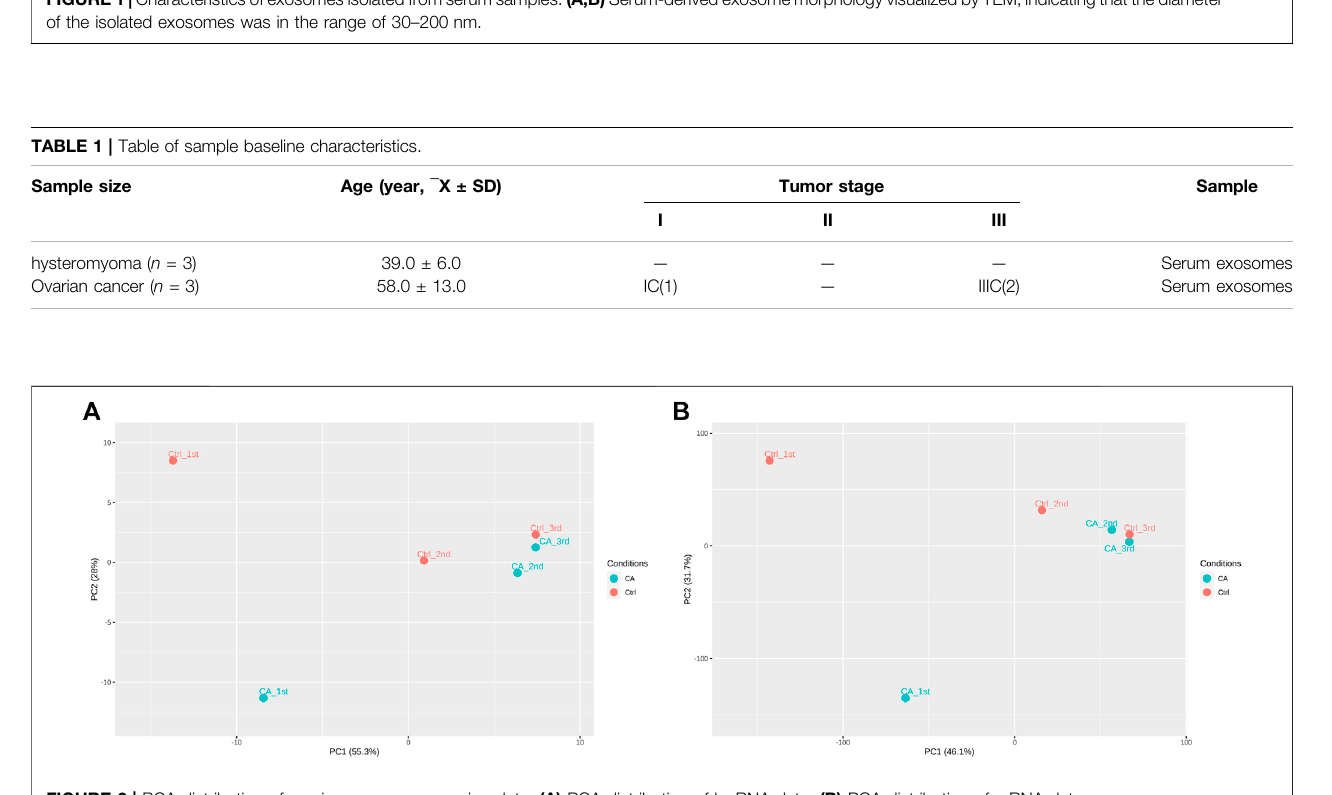
Frontiers in Genetics |